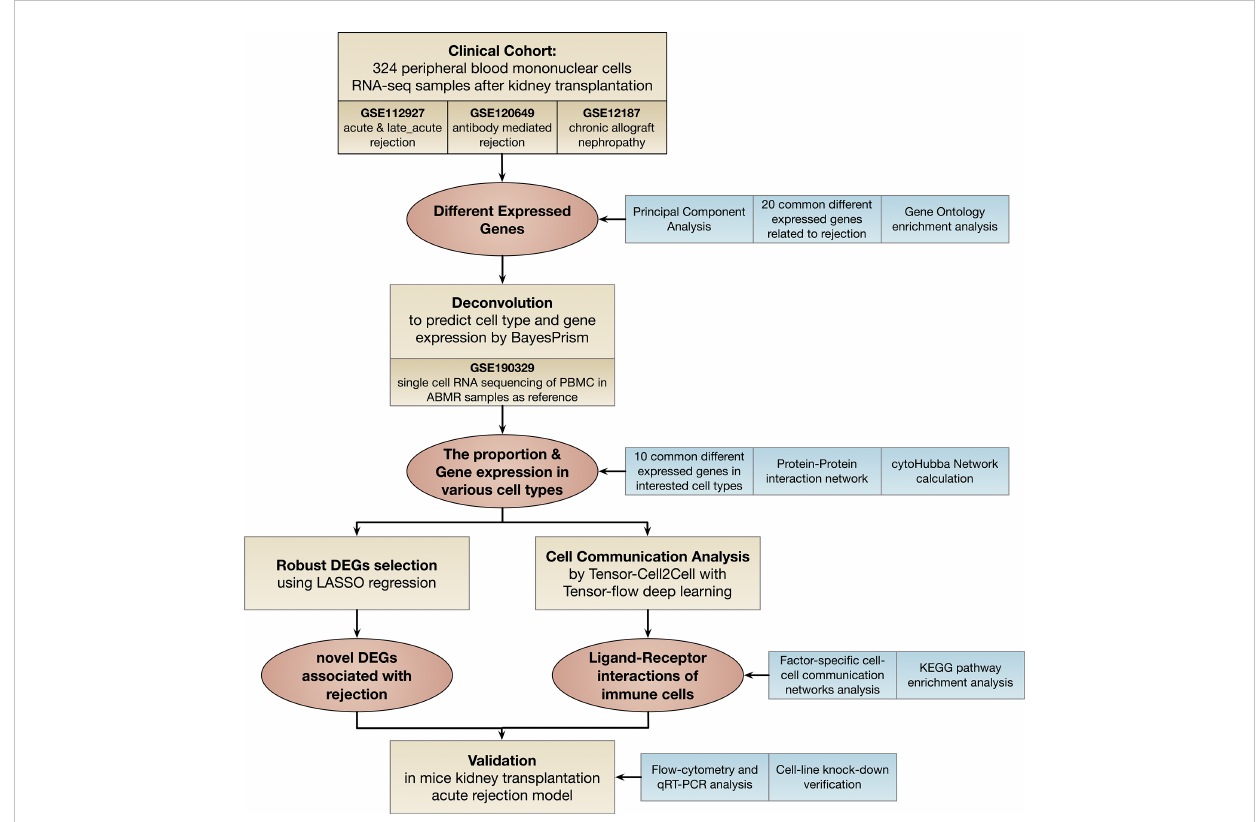
FIGURE 1 Flowchart of this study. DEGs: different expressed genes; LASSO: least absolute shrinkage and selection operator; KEGG: Kyoto Encyclopedia of Genes and Genomes; qRT-PCR: real-time quantitative reverse transcription polymerase chain